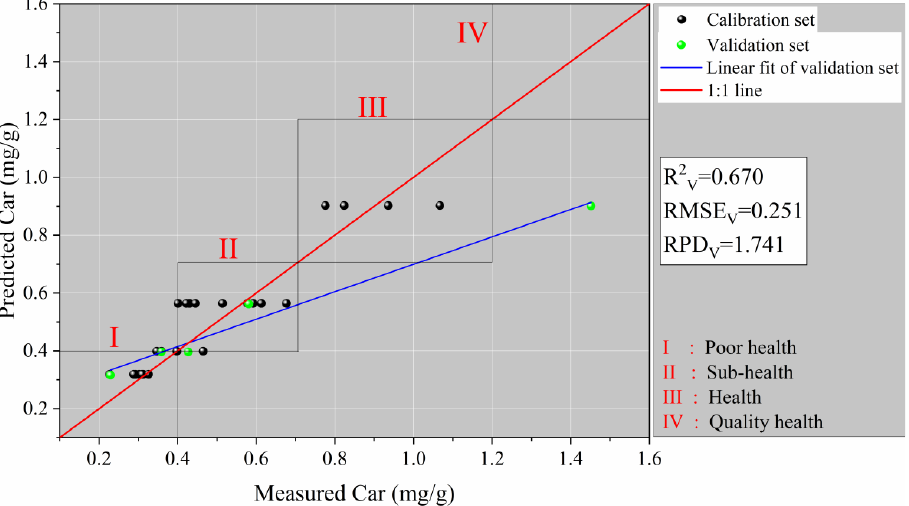
Figure 12. Scatter plot of the optimal CART-DT model for carotenoid content estimation in PeITCs.